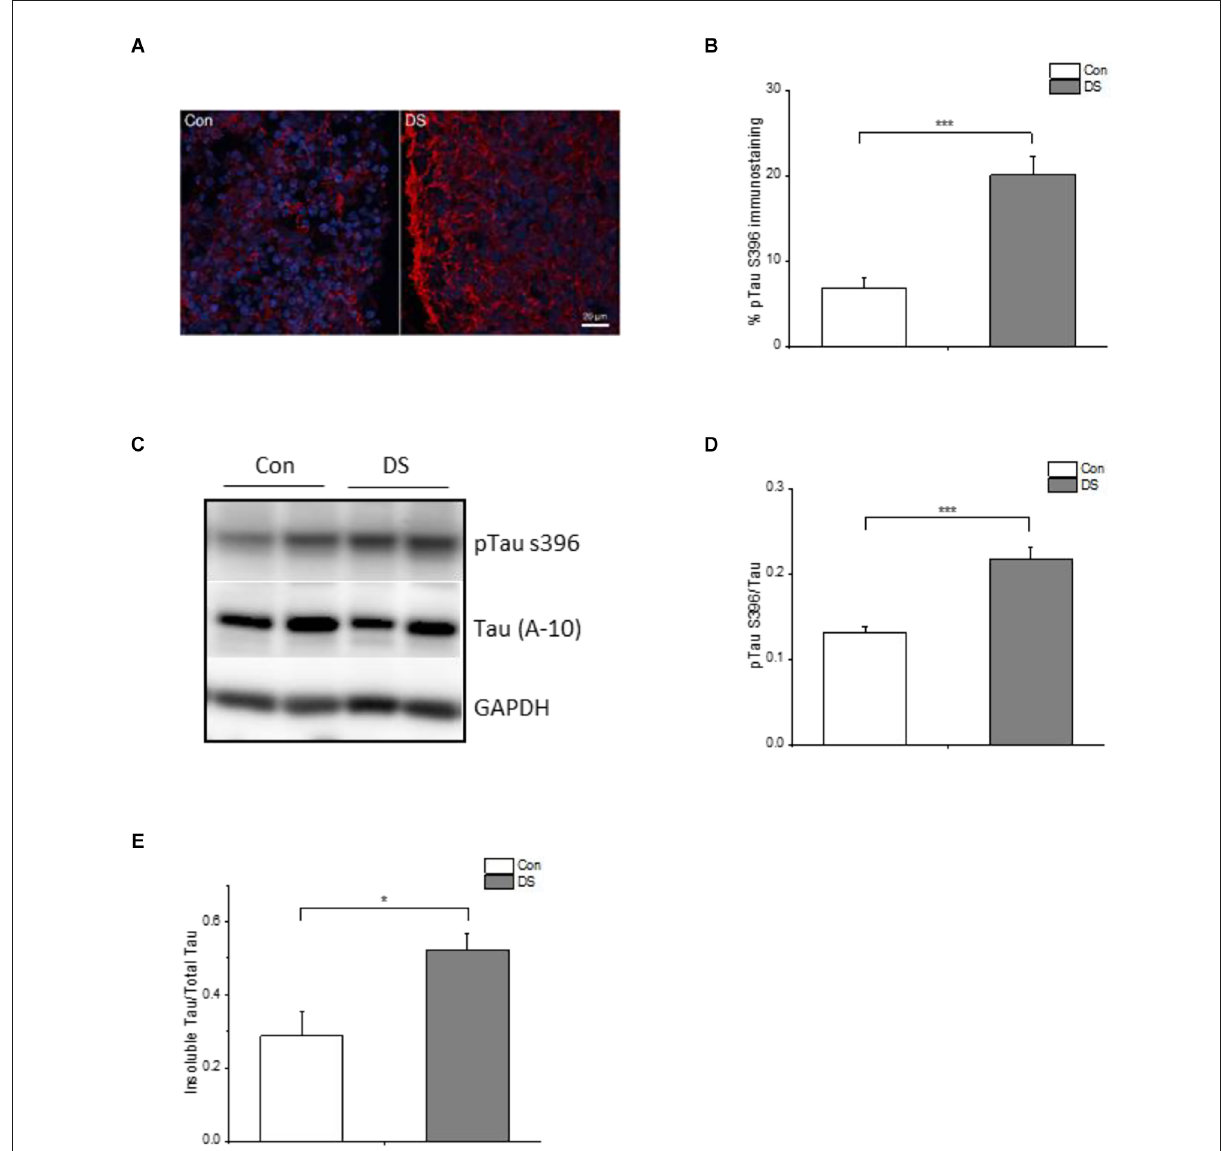
FIGURE4 Tau pathology in DS iPSCs-derived cortical organoids. (A) A representative pTau S396 (red) and DAPI (blue) immunostaining in 12 weeks DS and isogenic control organoids. (B) Immunohistochemical analysis of pTau S396 revealed a significantly increased pTau S396 immunoreactivity in DS organoids ( n = 24–28, p < 0.001). (C) A representative Western blot of pTau S396 and Tau expression in 12 weeks DS and isogenic control organoids. (D) Immunoblotting analysis of pTau S396 and Tau revealed a significantly increased pTau S396/Tau ratio in DS organoids ( n = 6, p < 0.001). (E) Both soluble and insoluble Tau in 12 weeks of DS and control organoids are measured and Elisa data revealed that DS organoids have an increased insoluble Tau/total Tau (soluble Tau + insoluble Tau; n = 6, p < 0.05). * p < 0.05, and *** p < 0.001 vs.